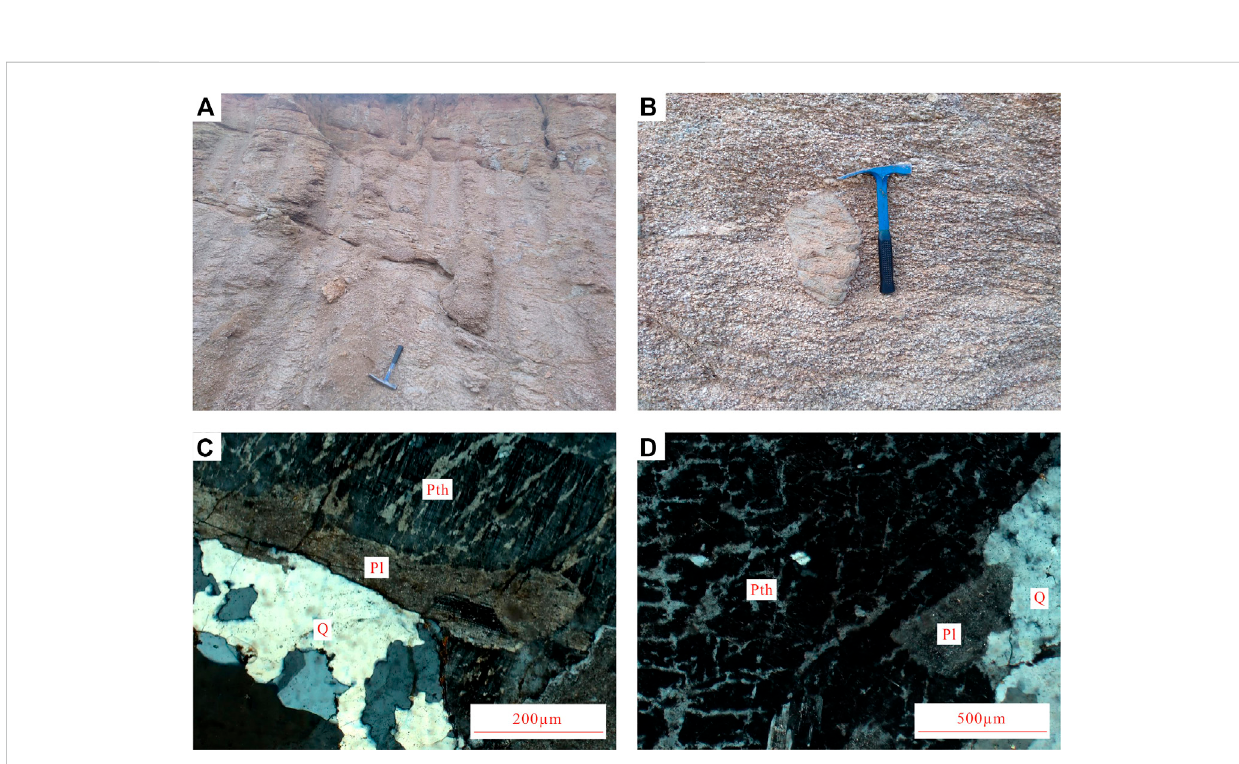
FIGURE 3 Macrofeatures and photomicrographs of the granite in Chuhuertu. (A) Macrofeatures; (B) fi eld occurrence; (C,D) micrographs of the granite. Pl, plagioclase; Pth, perthite; Q, quartz.